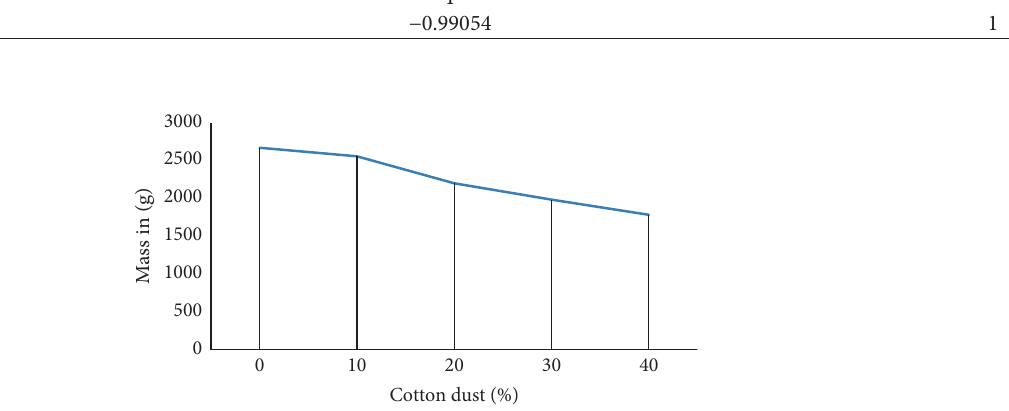
Figure 11: Effect of cotton microdust ratio on the mass of bricks. Table 10: ANOVA for unit weight of